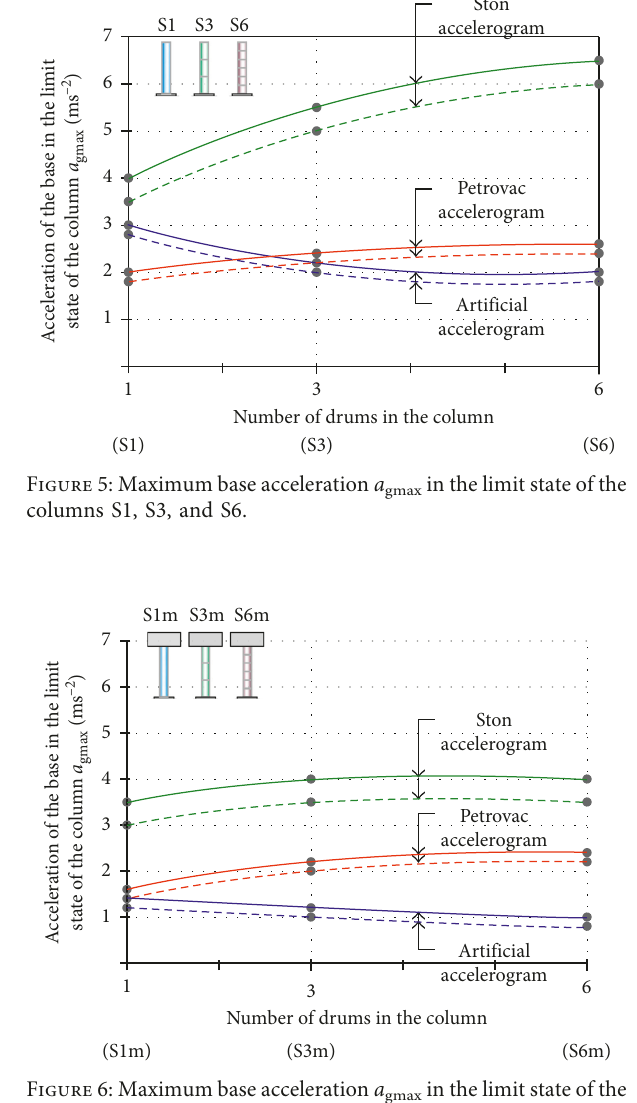
gmax in the limit state of the